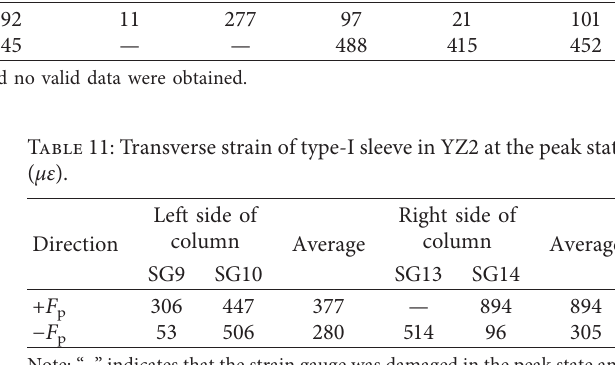
Figure 23: Hysteresis curves for transverse strain of type-II sleeve in YZ2. (a) Strain gauge near the rebar (SG12). (b) Strain gauge near the rebar (SG16). Table 10: Transverse strain of type-I sleeve in YZ1 at the peak state ( με ). Left side of column Right side of column Direction Average